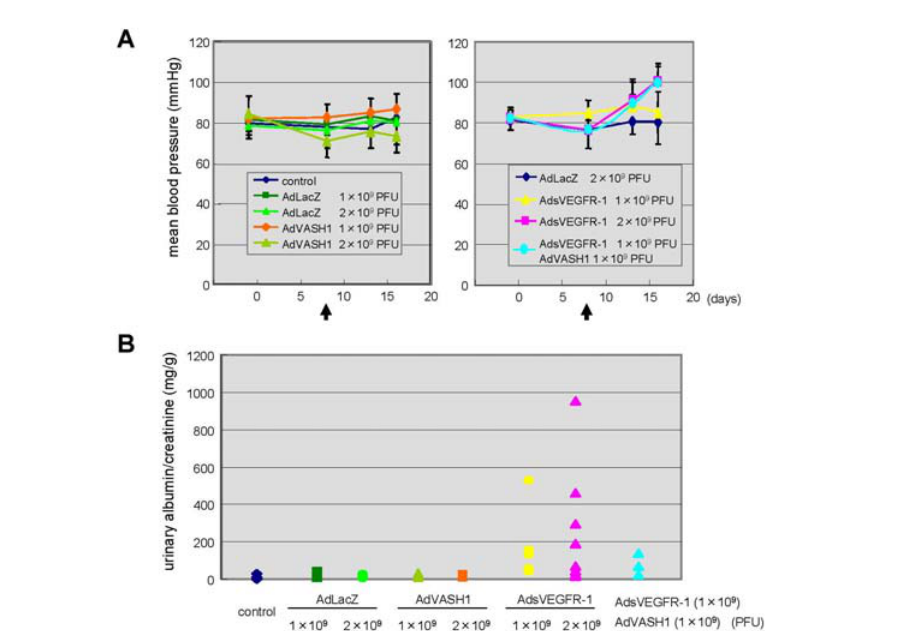
Figure 5. Different effects of sVEGFR-1 and VASH1 on blood pressure and urinary albumin